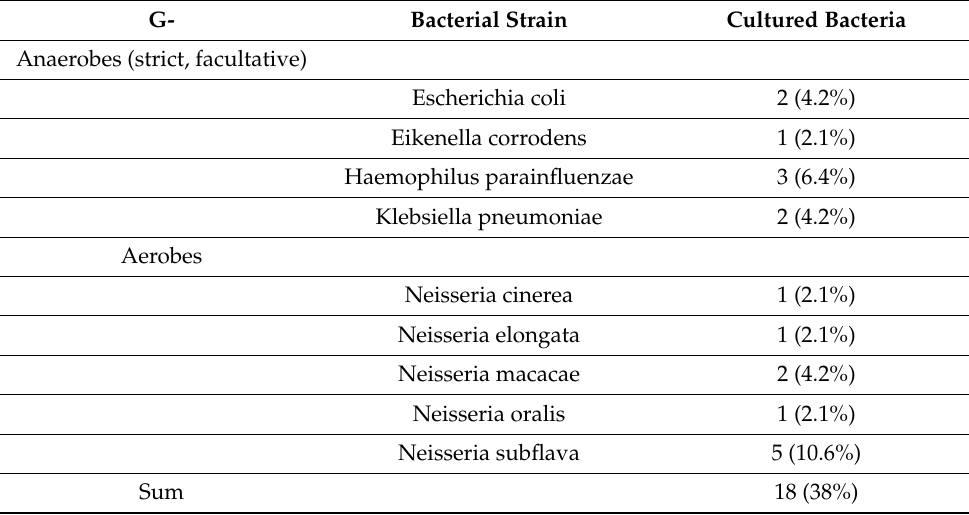
Table 4. Gram-negative bacteria detected in post-extraction tooth socket. G- Bacterial